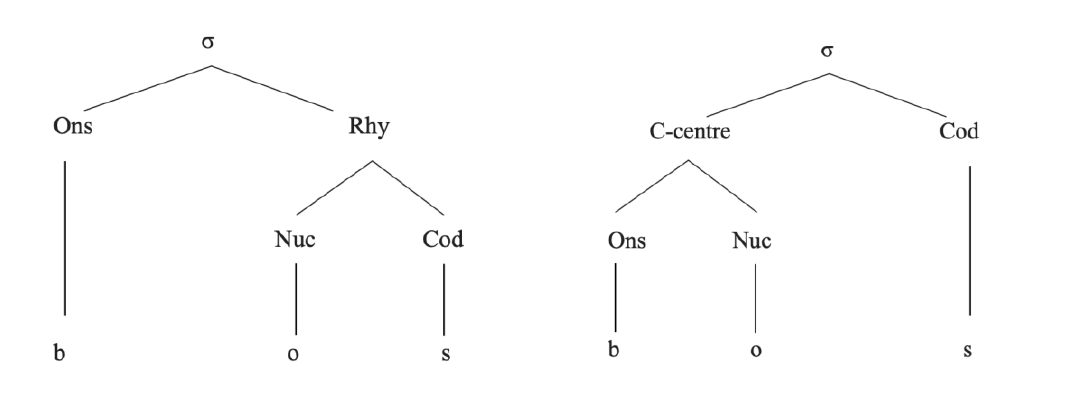
Figure 1. Syllable trees for voz (‘voice’, [ˈbos]) according to rhyme hypothesis (left panel) and c-centre hypothesis (right